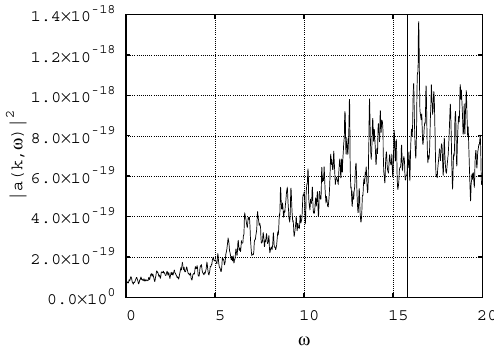
Figure 21. Spectral line of the harmonic k = (0, 250). The conden- sate was